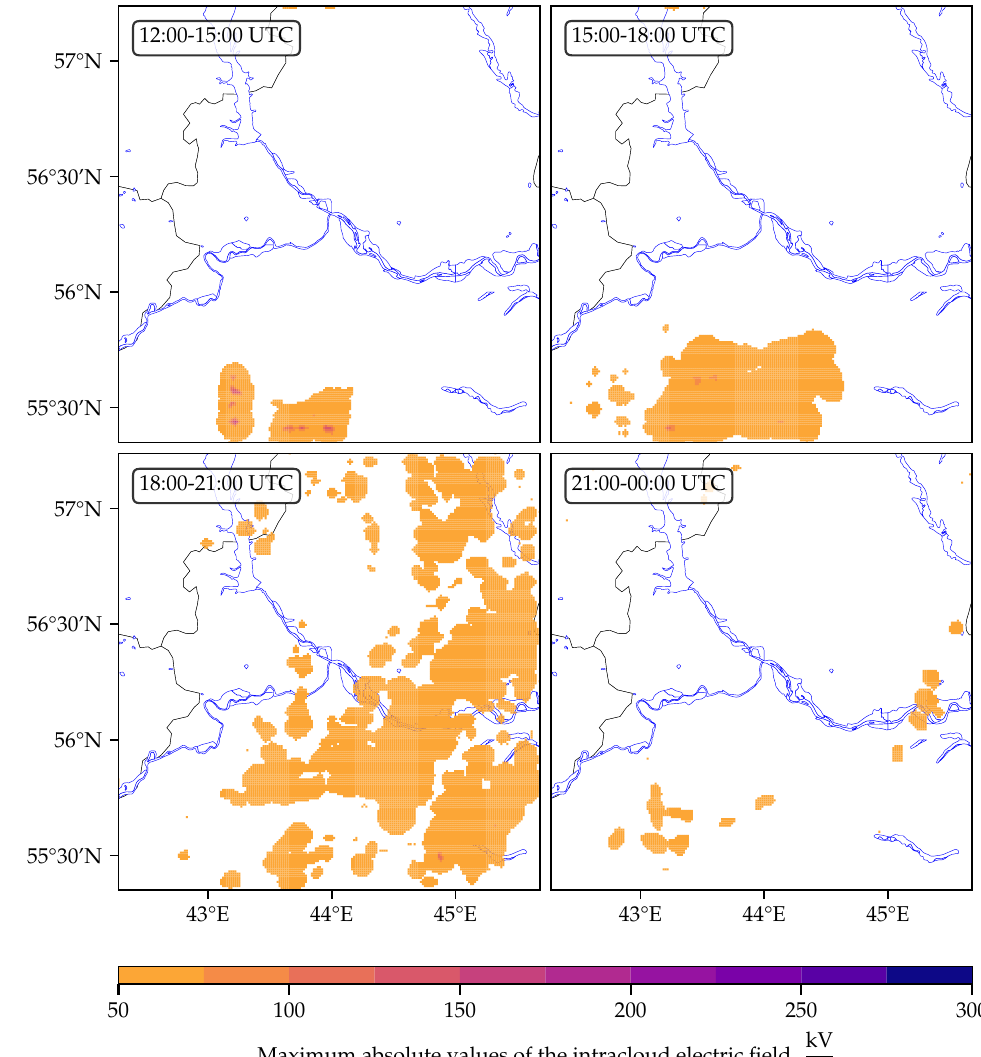
Figure 10. Maximum absolute values of the intracloud electric field strength every 3 h from 12:00 13 July 2020 to 03:00 14 July 2020, obtained by modeling with aerosol parametrization of the